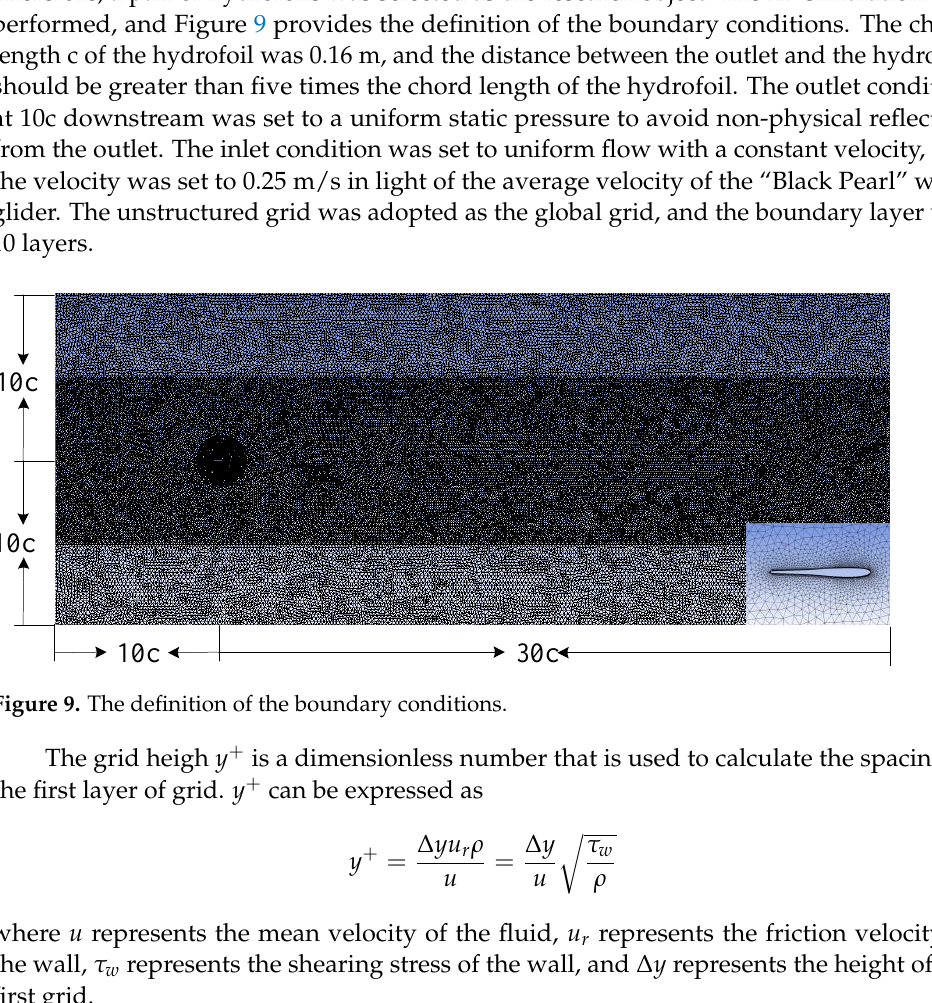
Table 4. The numerical results of the different levels of cells.